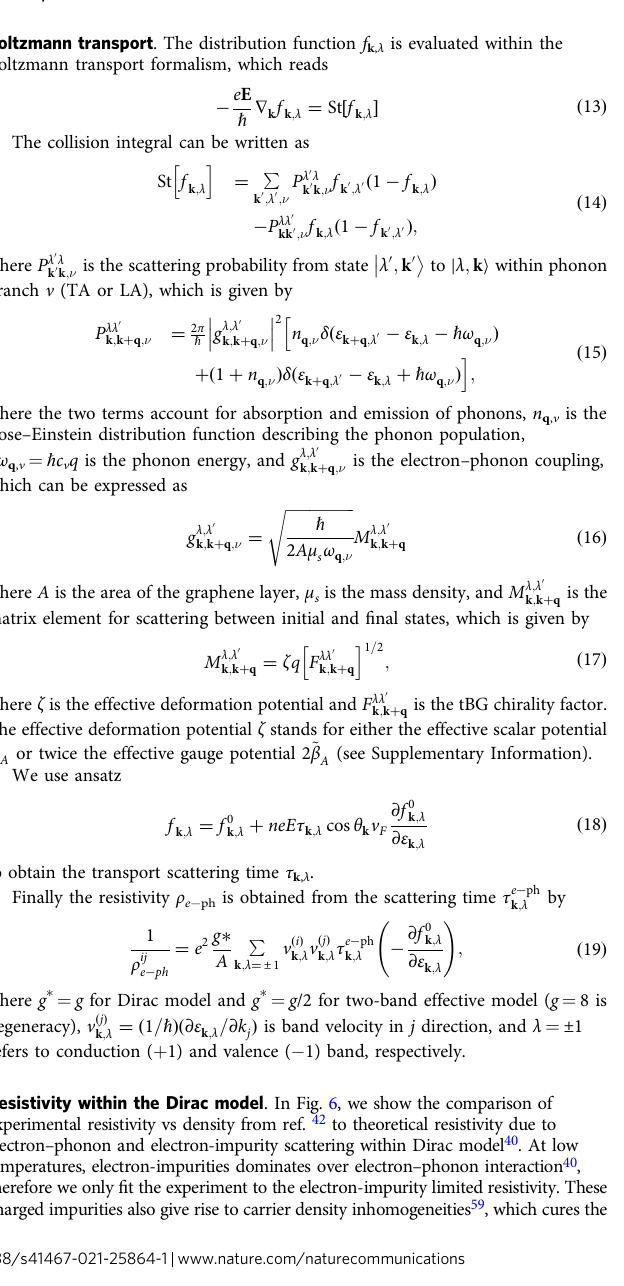
eight data sets of varying twist angle, temperature, and carrier